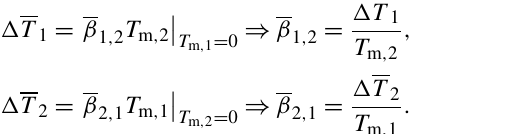
Table 2. A summary of the Ti thin-film dual-element device dimen-